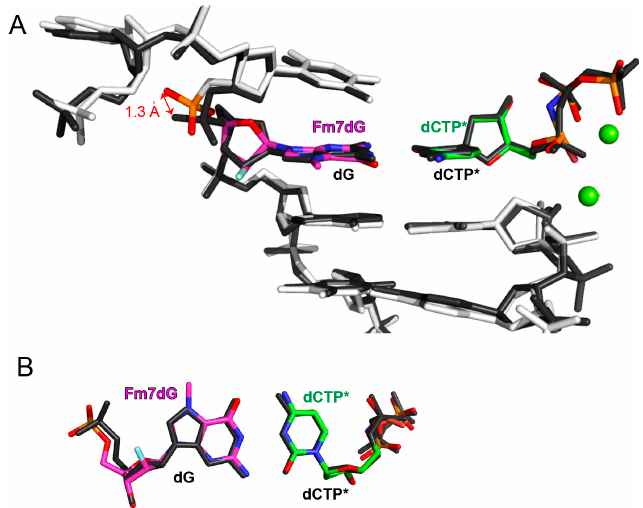
Figure 4. Superpositions of DNA conformation of the pol η -Fm7dG:dCTP* and published pol η -